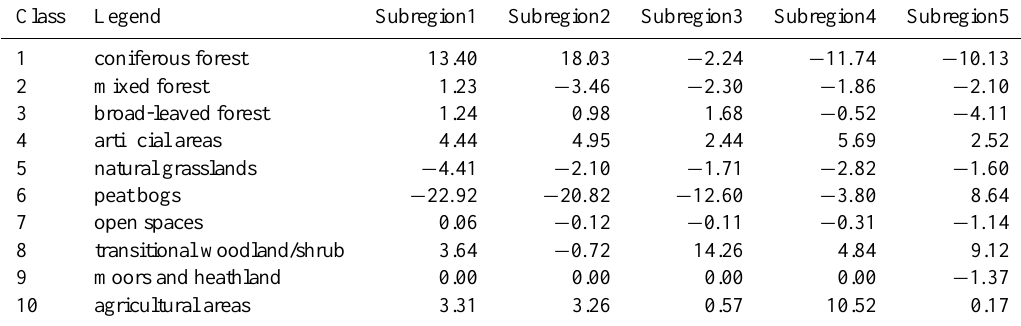
Table 1. Changes of fractional coverage (%) of the 10 land cover classes from the 1920s to the 2000s (FNFI10–FNFI1) in the five subregions. Class Legend Subregion1 Subregion2 Subregion3 Subregion4 Subregion5 1 coniferous forest 13.40 18.03 mixed forest 1.23 broad-leaved forest 1.24 artificial areas natural grasslands − 4 . 41 peat bogs open spaces 0.06 moors and